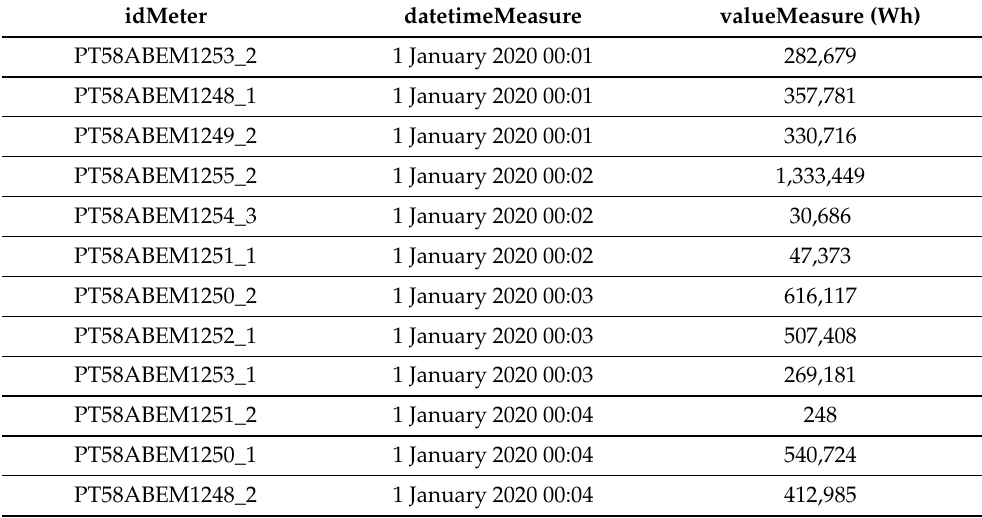
Table 3. Meter table